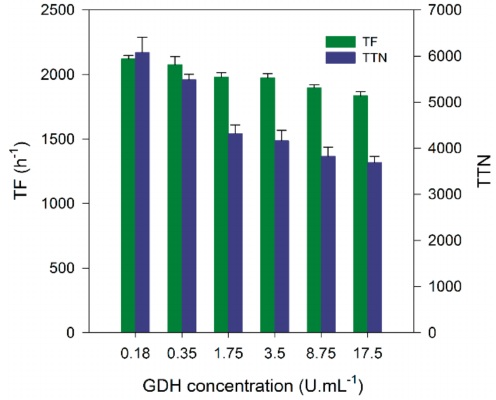
Figure 1. Effect of glucose dehydrogenase (GDH) on initial activity (TF after 1 h) and stability (TTN after 17.5 h) of 1-octanol production from n -octane by CYP153A6. Reaction conditions: 1 mL aqueous reaction mixtures containing 1 µ M CYP153A6, 1 µ M FdR, 6 µ M Fdx, 10 mg mL − 1 BSA, 0.5 U mL − 1 catalase, 0.1 mM NADH, 0.18–17.5 U mL − 1 GDH, 200 mM glucose, buffer: 200 mM Tris-HCl (pH 8) with 250 µ L n -octane added, 20 ◦ C, 200